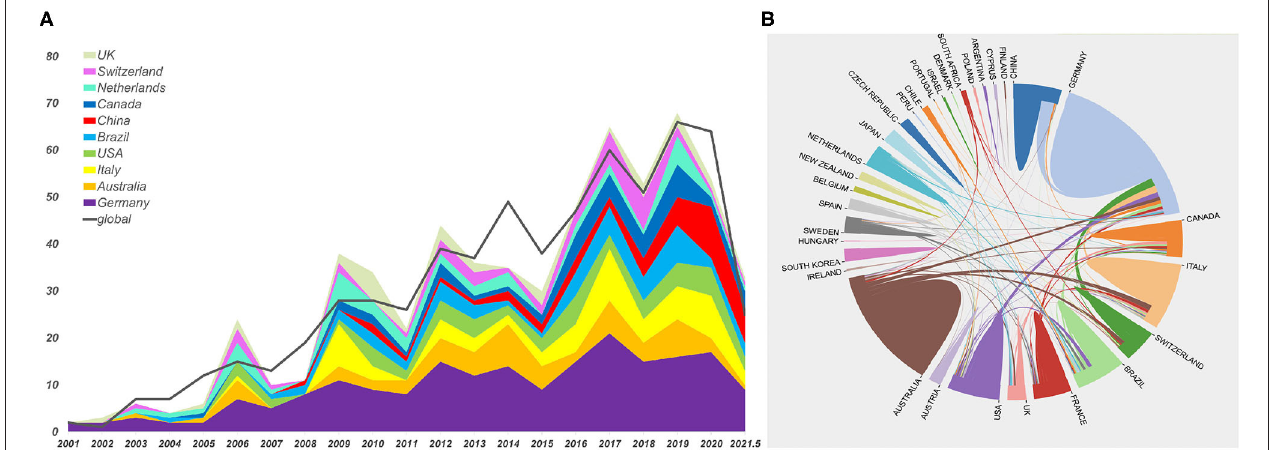
FIGURE 2 | The number of annual publications, growth trends (A) , and country coauthorship analysis (B) of global and top 10 countries on electrical impedance tomography (EIT) applications in clinical lung monitoring research from 2001 to May 29, 2021. (A) The gray line indicated the trend of the annual world publication number. The color indicated different countries. The width of the color plate indicated the annual publication number of each country. (B) The color indicated countries; color plate size indicated the number of publications; the thickness of lines indicated linkage strength.